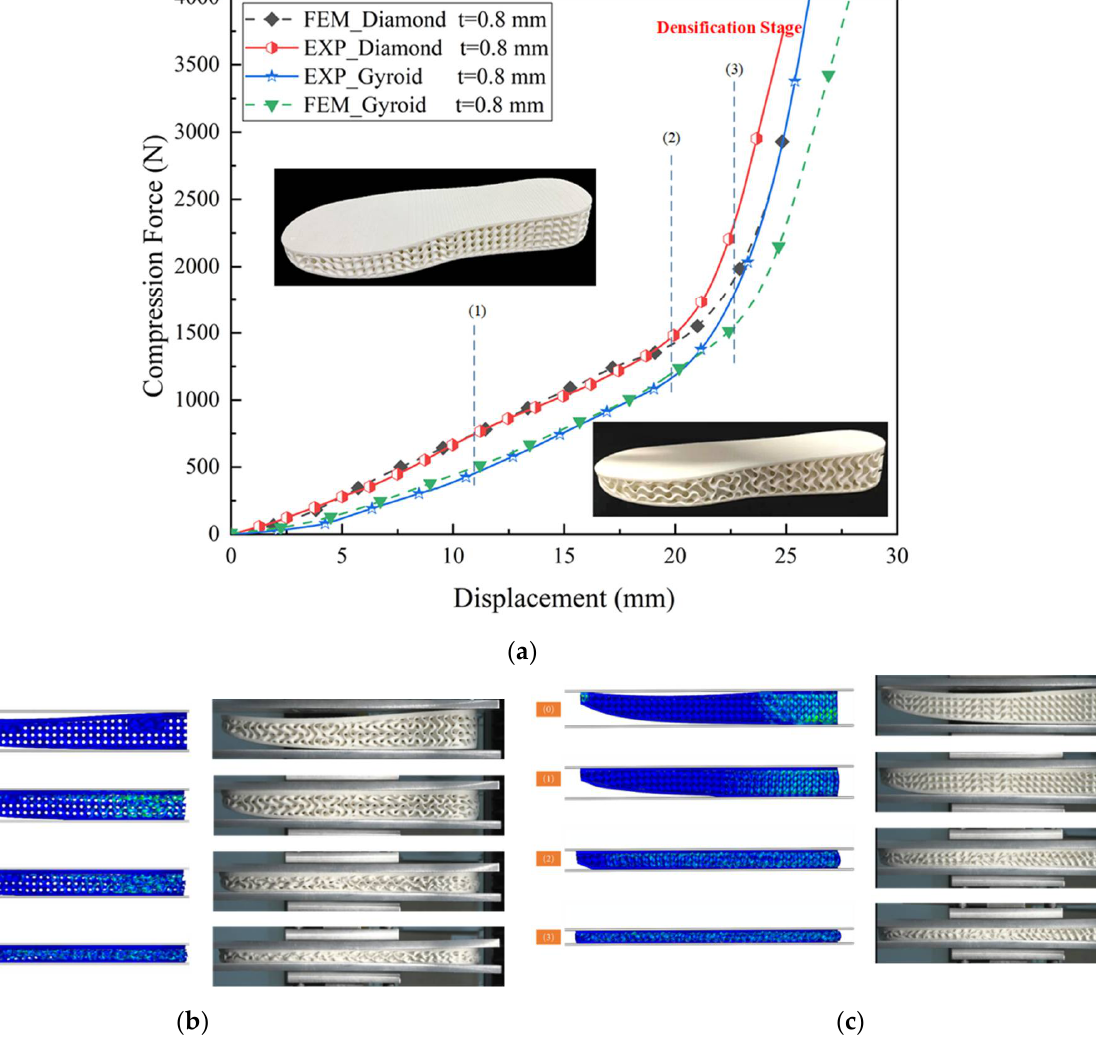
Figure 6. Comparison between compression test and FE results under quasi-static conditions for Gyroid and Diamond soles with a thickness of 1 mm. ( a ) Compression force versus displacement curves: (1) 11 mm; (2) 20 mm; (3) 23 mm; ( b ) compression deformation process of the Gyroid sole; ( c ) compression deformation process of the Diamond sole.